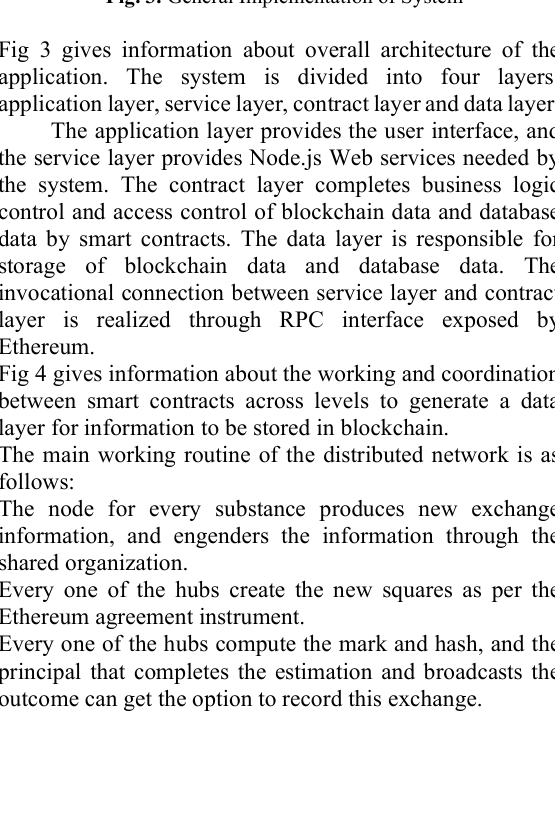
Fig. 3. General Implementation of